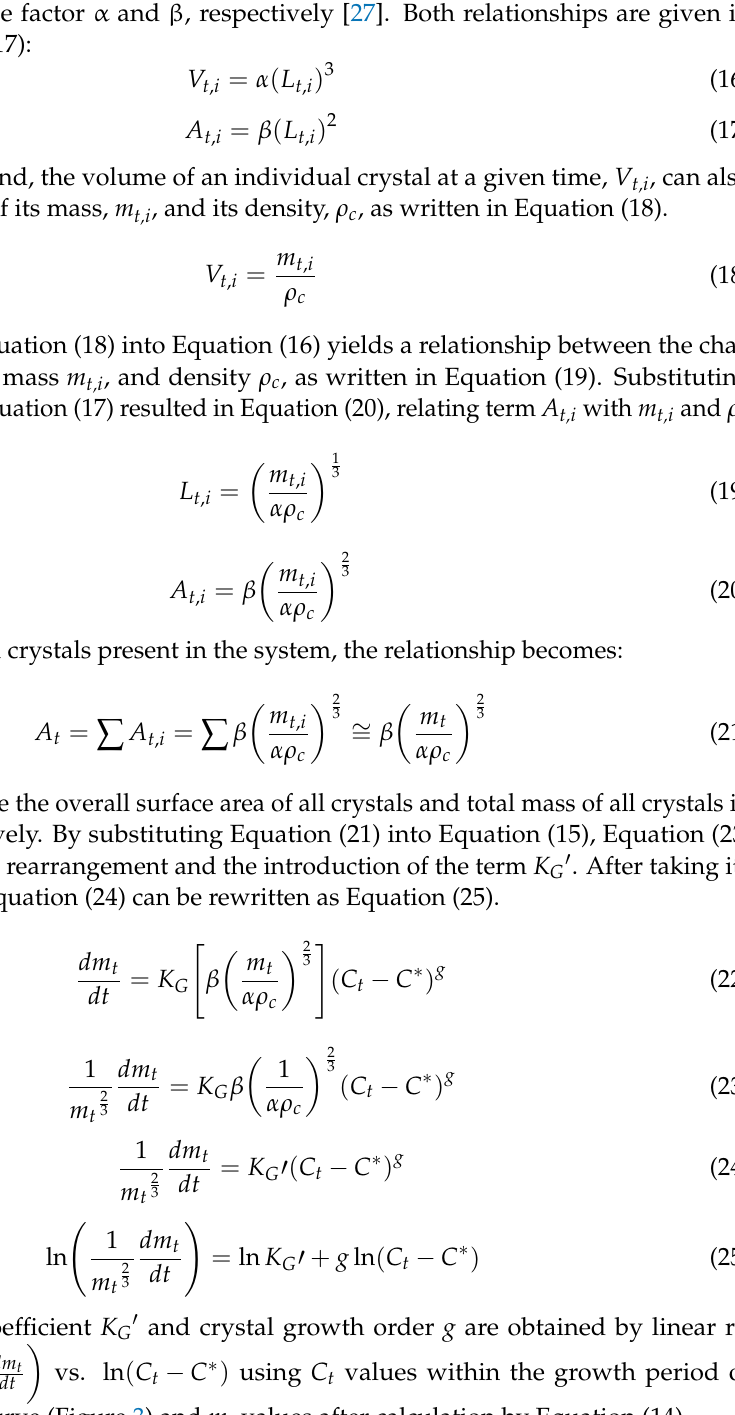
desupersaturation curve (Figure 3) and m t values after calculation by Equation